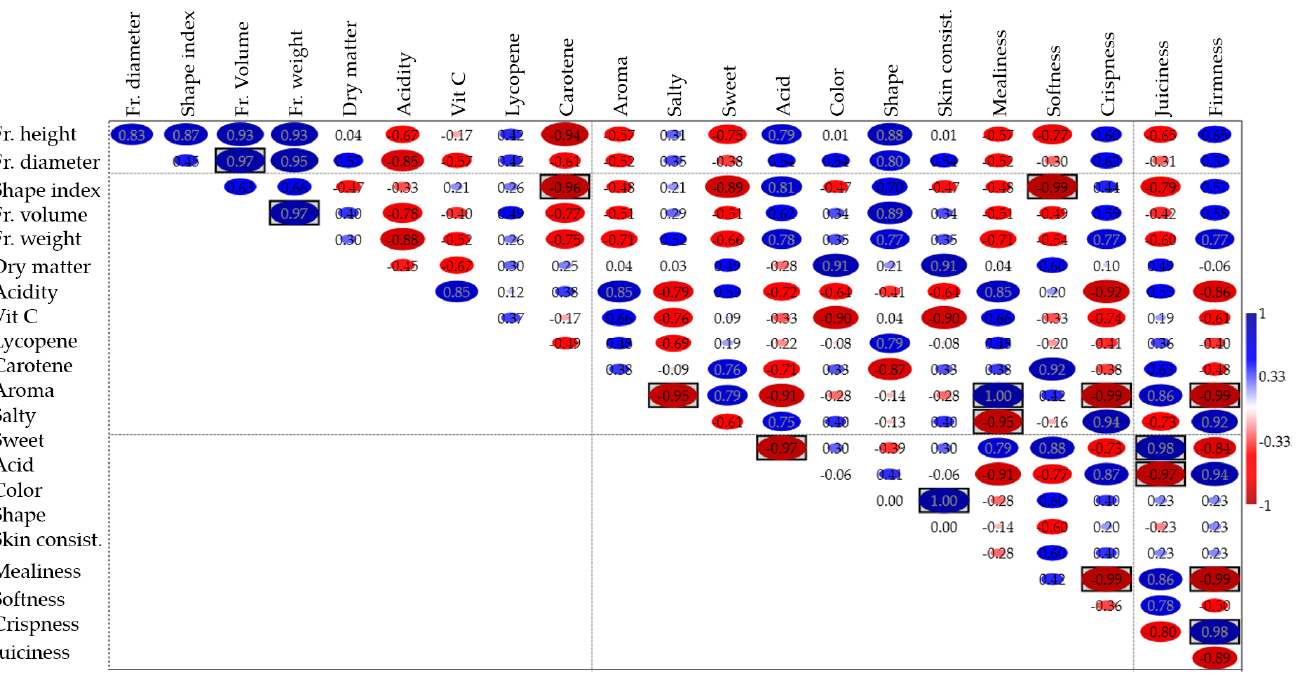
Figure 6. Phenotypic correlations between the pairs of traits analyzed. Correlations were calculated from the mean values of each of the four genotypes characterized. Positive correlations are displayed in blue and negative correlations in red. The color intensity and the size of the circle are proportional to the correlation coefficients. The grey background boxes illustrate the significant values at the level of p < 0.05 (two ‒ tailed).